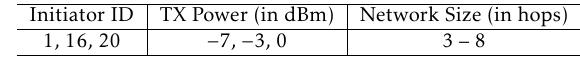
Table 1. Evaluation settings in the FlockLab